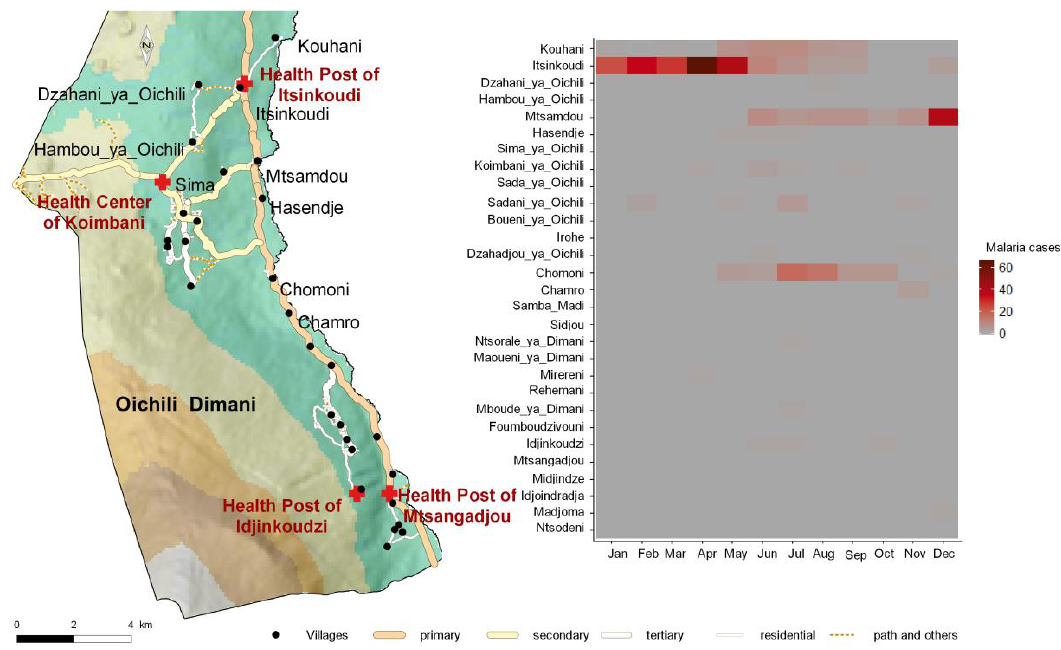
Figure 8. Monthly malaria cases by locality of the Oichili Dimani health district in 2016 and location map (localities are sorted from north to south).